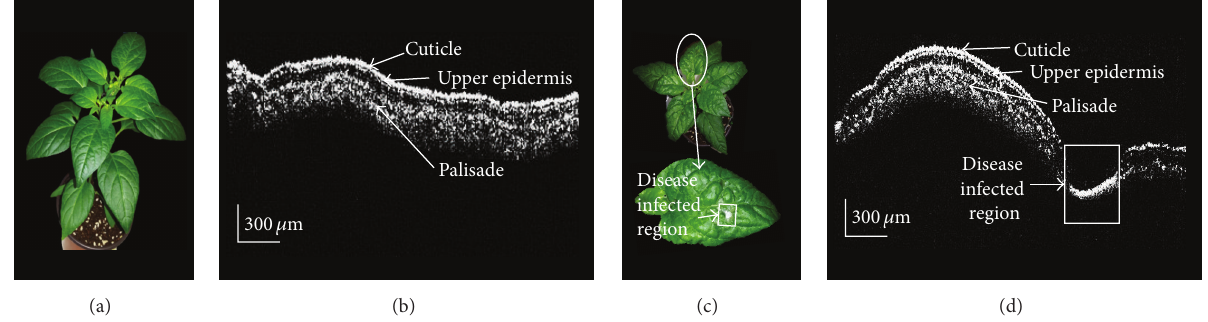
Figure 2: Photographs of Capsicum annuum plant leaves and OCT cross-sectional images. Healthy plant used for imaging is shown in (a) alongwithitsrespective2DOCTimage(b).Disease-inducedplantpotusedforimagingisshownin(c)withits2DOCTimage(d),highlighted with white box as disease infected